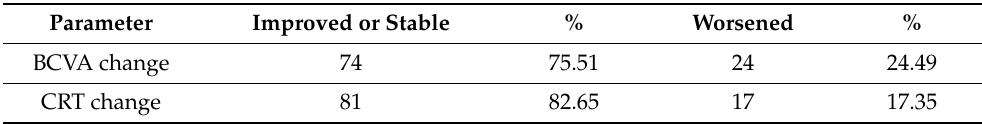
Table 3. Stratification of responders and non-responders according to changes in BCVA and CRT at 12 months.